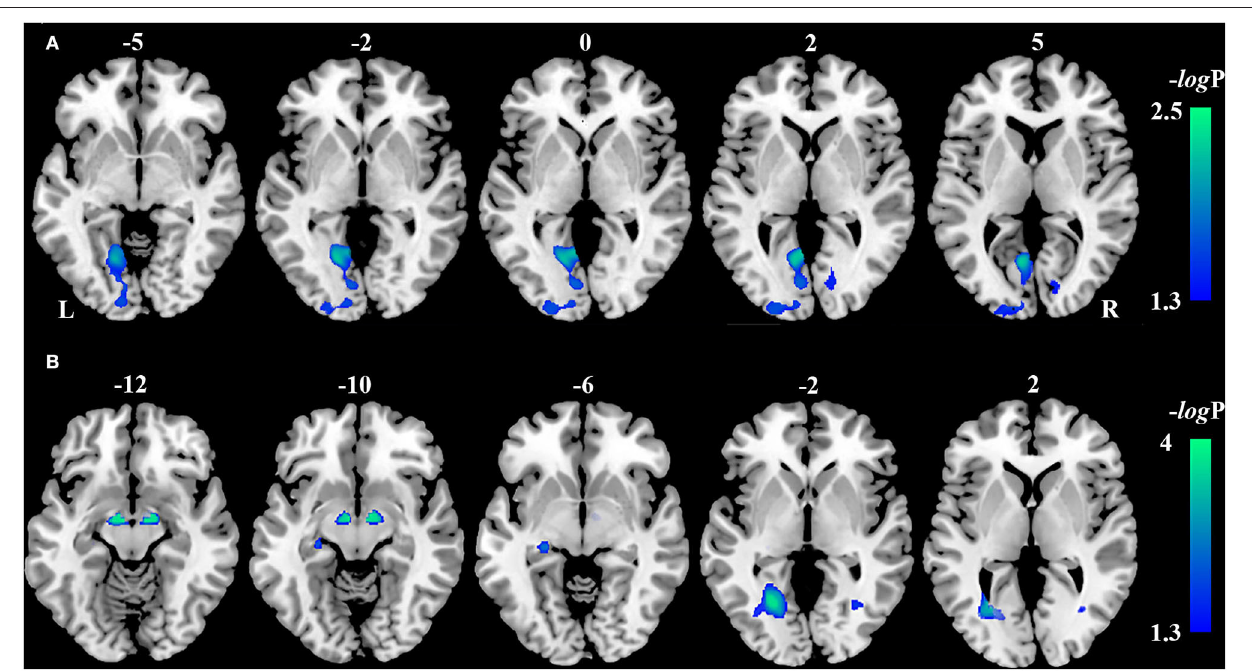
FIGURE 1 | Inter-group differences in gray matter volume (GMV) and white matter volume. (A) The difference in GMV between the LHON and HC was tested using a voxel-wise non-parametric permutation test corrected for age and gender ( p < 0.05, TFCE-FWE corrected). Chronic LHON had significantly lower GMV in the bilateral CG than in the HC (cool color). (B) The difference in WMV between the LHON and HC was tested using a voxel-wise non-parametric permutation test corrected for age and gender ( p < 0.05, TFCE-FWE corrected). Chronic LHON had significantly lower WMV in the bilateral OR, bilateral OT, and left LGN than in the HC (cool color). Color bar represents the -log(p) value. CG, calcarine gyrus; FWE, family-wise error; GMV, gray matter volume; HC, healthy controls; LGN, lateral geniculate nucleus; LHON, Leber’s hereditary optic neuropathy; OR, optic radiation; OT, optic tract; TFCE, threshold-free cluster enhancement; WMV, white matter volume.